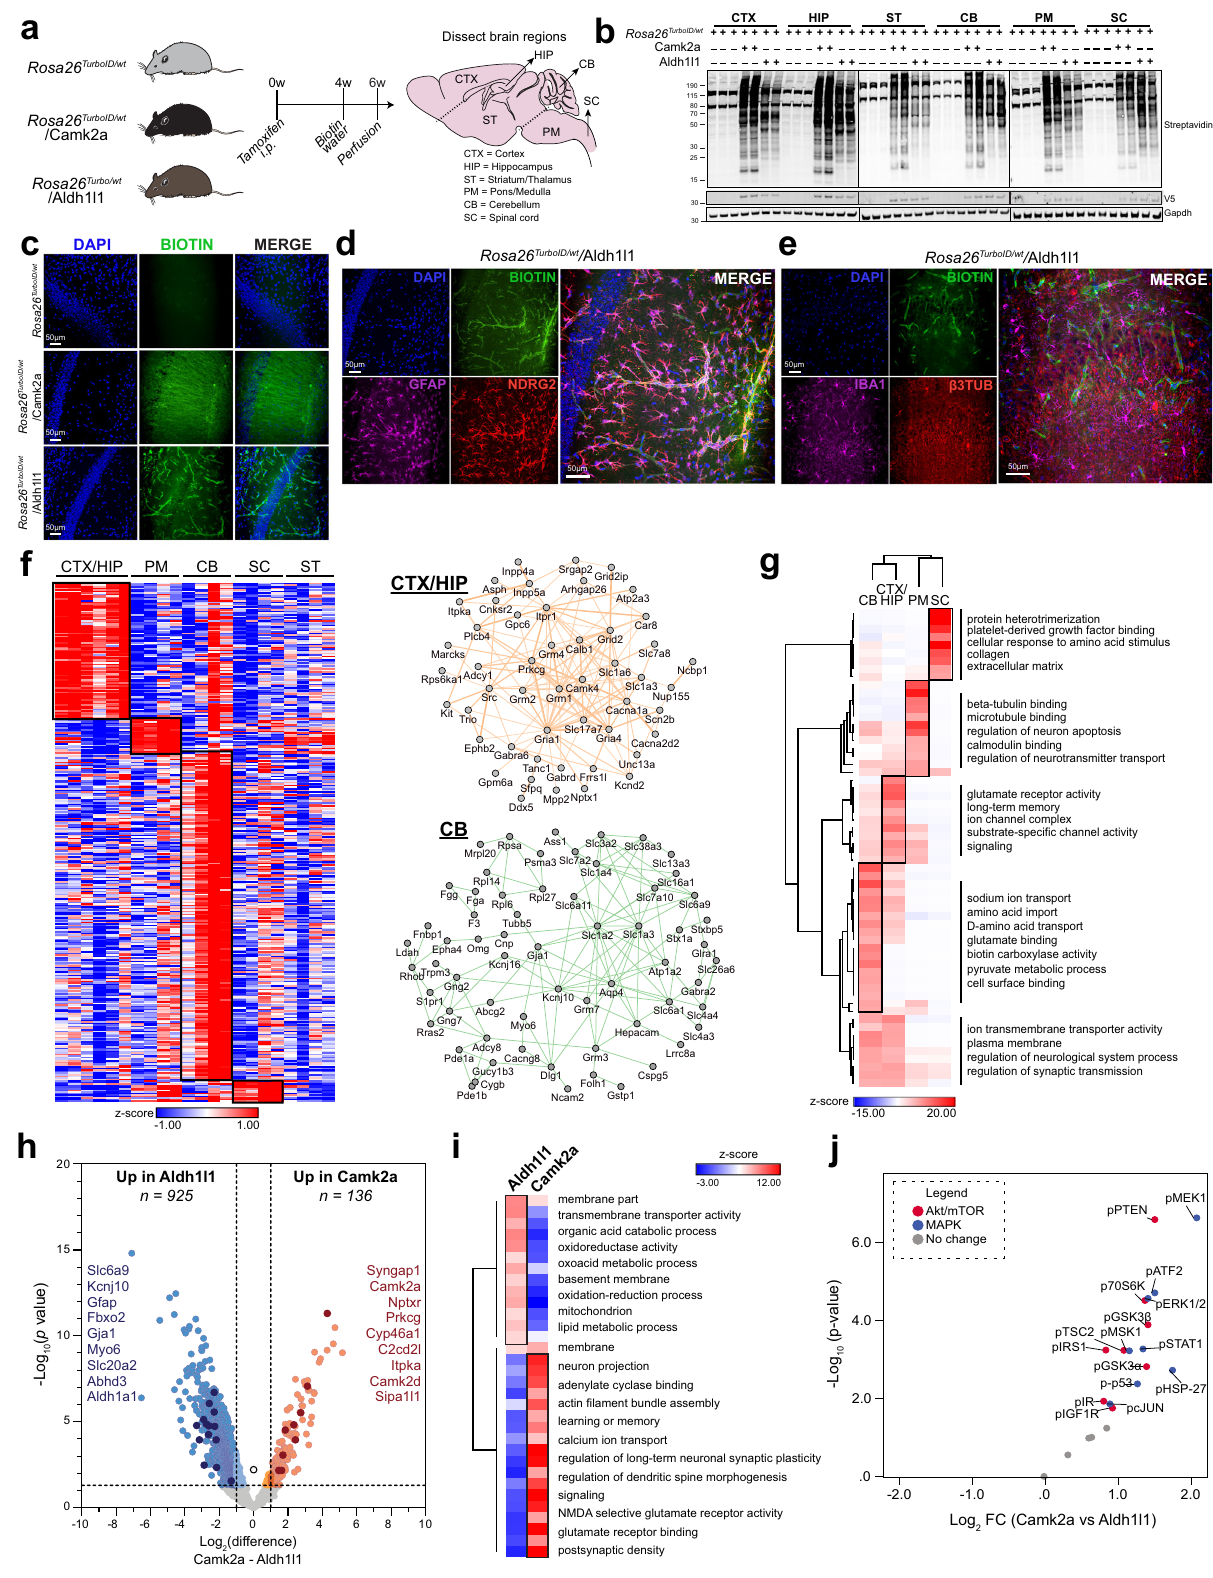
Camk2a brain regions displayed a higher degree of labeling compared to Rosa26 TurboID/wt /Aldh1l1 brain regions. We also con fi rmed TurboID protein expression via detection of V5 (Fig. 5b). Immuno fl uorescent imaging of brain sections